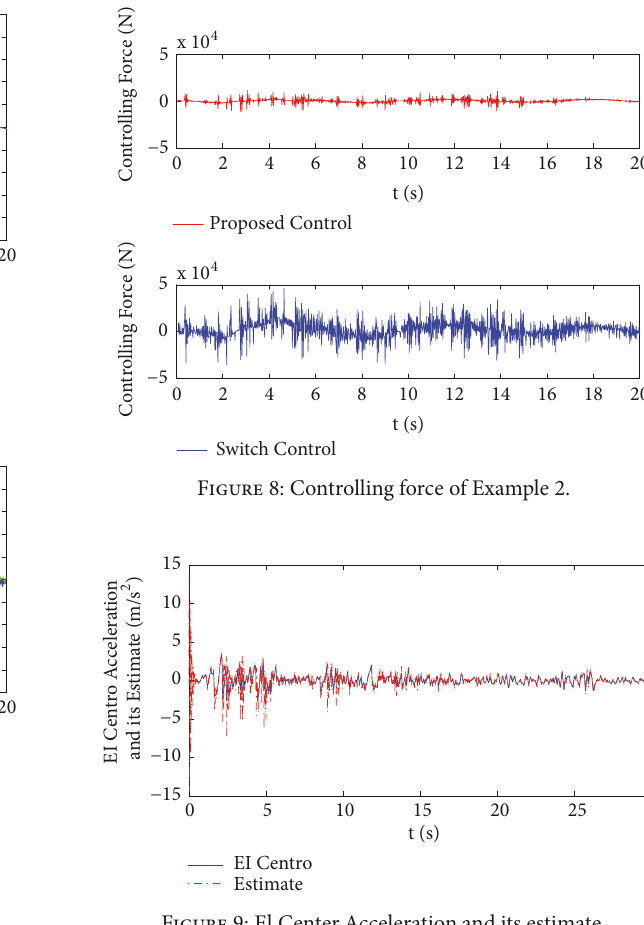
Figure 9: El Center Acceleration and its